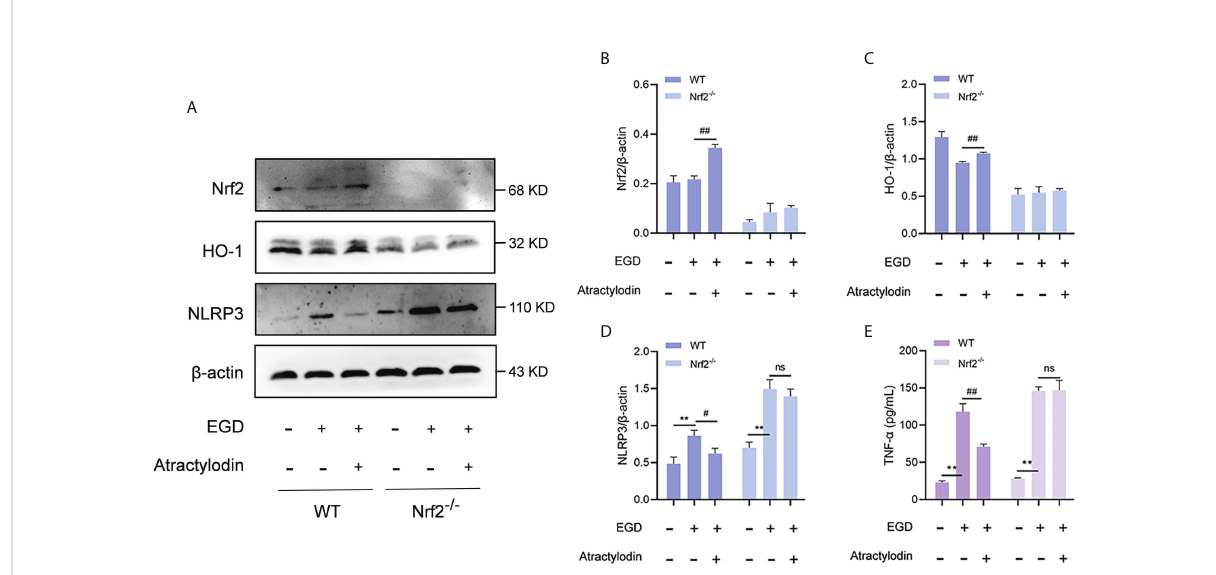
FIGURE 8 The inhibitory effect of atractylodin on NLRP3 in fl ammasome was dependent upon Nrf2 activation. Peritoneal macrophages from wide-type (WT) and Nrf2 knock out (Nrf2 -/- ) mice were isolated and infected with L. monocytogenes EGD for 6 h in the presence or absence of atractylodin. (A – D) Representative immunoblots and quanti fi cation of Nrf2, HO-1, NLRP3 protein levels in WT and Nrf2 -/- mice. (E) Effects of atractylodin on the level of TNF- a secretion in the co-cultured supernatants. All data are presented as means ± SEM. ** P < 0.01 vs the vehicle control group; ns, P > 0.05, # P < 0.05 and ## P < 0.01 vs the EGD-infection